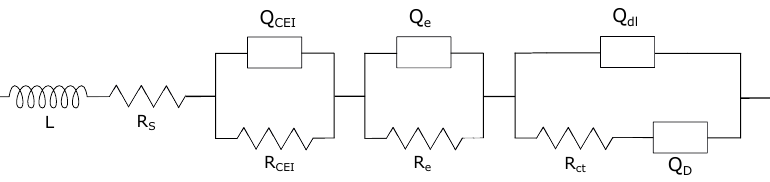
Figure 8. Equivalent circuit model used for EIS